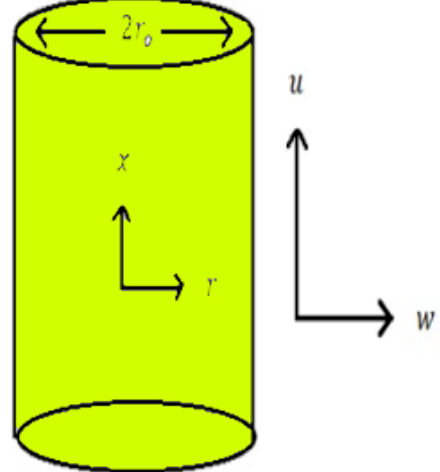
Figure 1. The configuration of the problem.